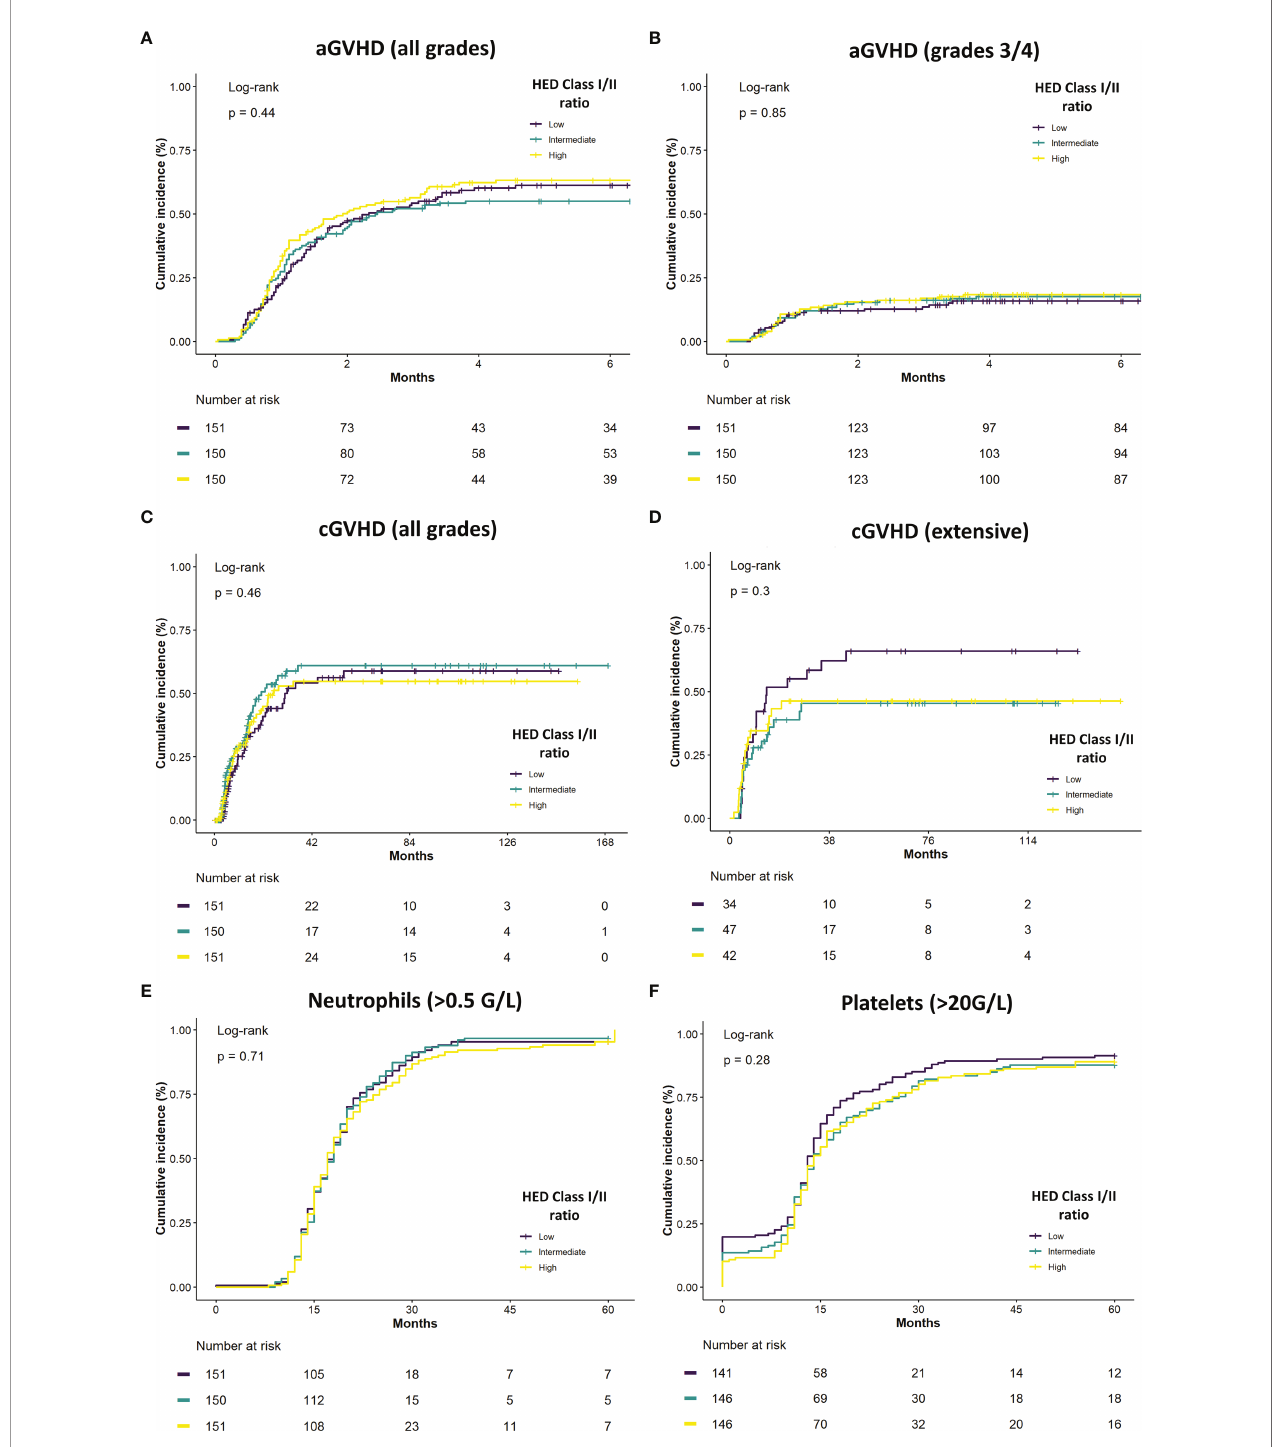
FIGURE 3 | Class I/class II HED ratio association with GVHD and neutrophil recovery. (A) Cumulative incidence of overall acute GVHD (aGVHD) according to class I/ class II HED ratio terciles in the overall cohort. (B) Cumulative incidence of severe grade 3/4 aGVHD according to class I/class II HED ratio terciles in the overall cohort. (C) Cumulative incidence of overall chronic GVHD (cGVHD) according to class I/class II HED ratio terciles in the overall cohort. (D) Cumulative incidence of severe grade 3/4 cGVHD according to class I/class II HED ratio terciles in the overall cohort. (E) Cumulative incidence of neutrophil recovery (> 0.5 G/L) according to class I/class II HED ratio terciles in the overall cohort. (F) Cumulative incidence of platelet recovery (> 20 G/L) according to class I/class II HED ratio terciles in the overall cohort. aGVHD, acute graft versus host disease; cGVHD, chronic graft versus host disease; HED, HLA evolutionary